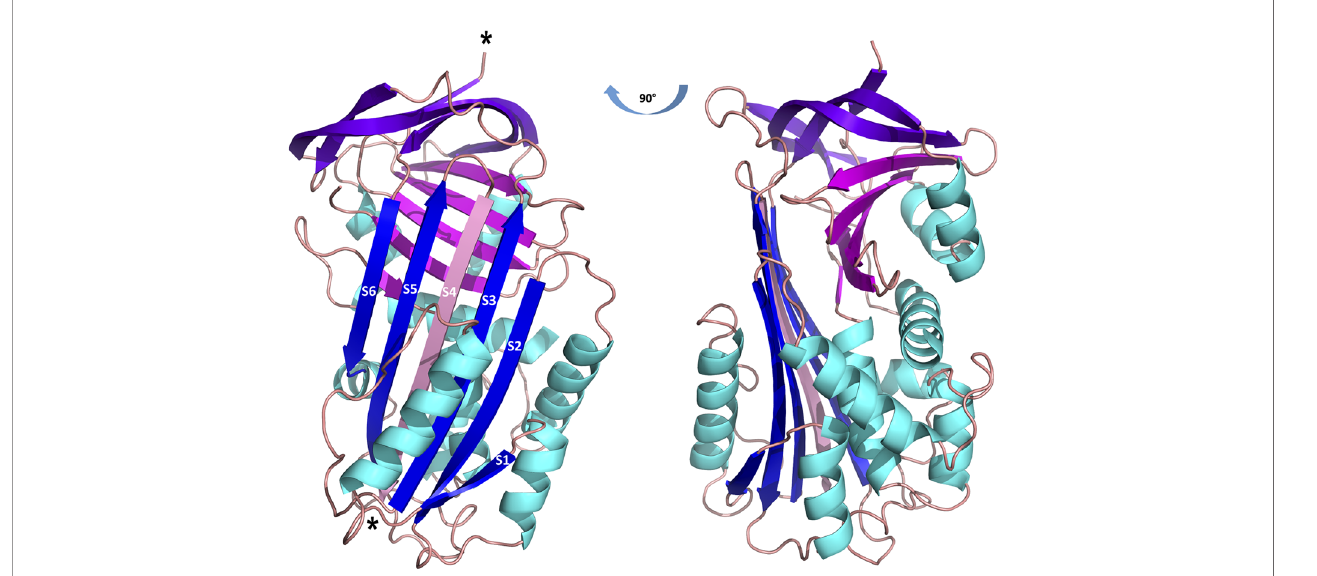
FIGURE 2 | Cartoon representation of the structure of cleaved Iripin-3. a -helices are colored cyan, b -sheet A is blue, b -sheet B is magenta, b -sheet C is purple, and loops are colored wheat. The insertion of the RCL hinge region between b -strands S3 and S5 (depicted in blue) resulted in the formation of an additional b -strand S4 (depicted in pink). Cleavage sites are marked with